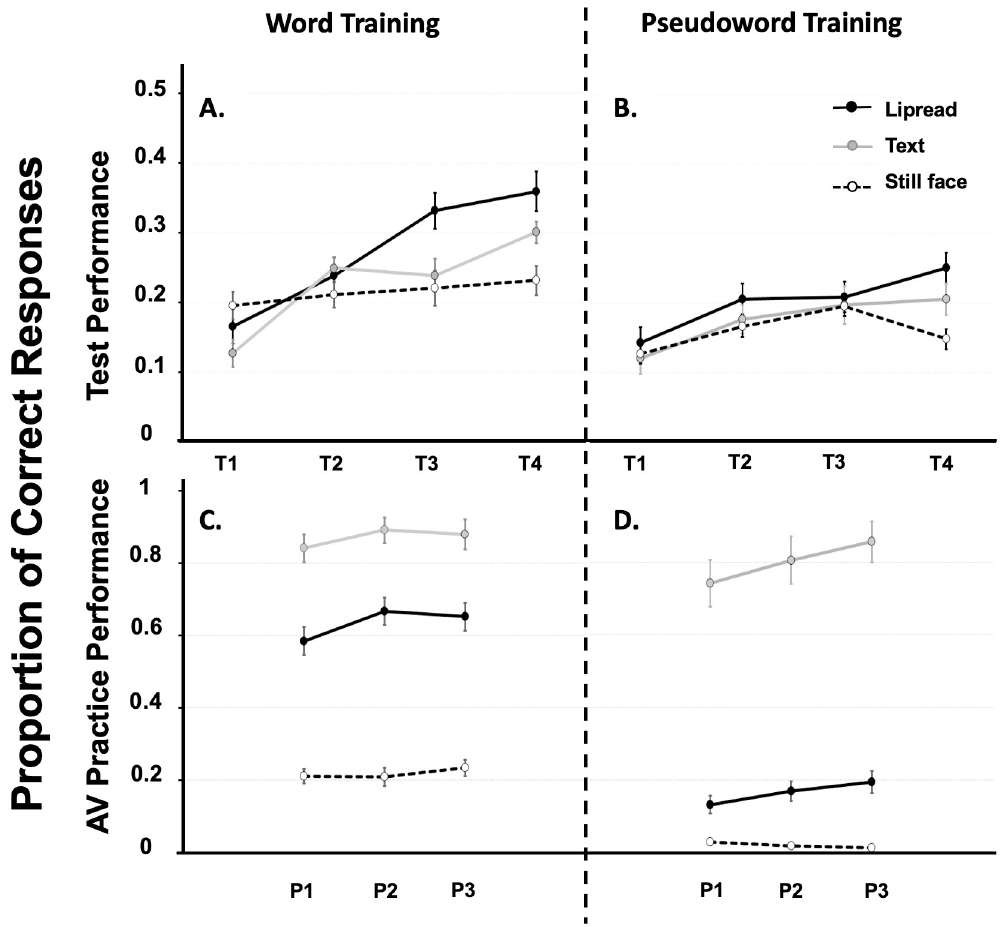
Fig 3. Proportion of correct responses during test and training blocks of Experiment 1. Grand average proportion of correct responses during test and training blocks for each type of training conditions (lipread speech, text, still face) and lexical status (words, pseudowords). The upper panels show accuracy of auditory-only word recognition during test blocks for participants trained with words (panel A) or pseudowords (panel B). The lower panels show accuracy during the audiovisual training blocks for words (panel C) or pseudowords (panel D). Error bars represent one standard error of the mean.